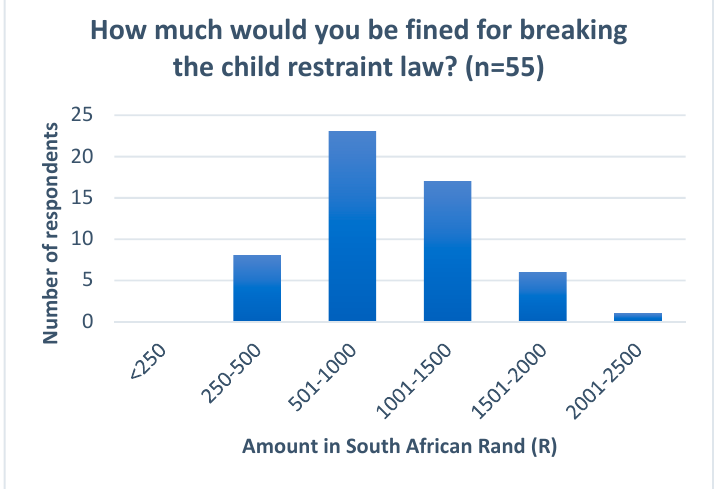
Figure 3. Survey respondent knowledge of fine penalty. Respondent knowledge of fine penalty for breaking the child restraint law. (NB Correct response was <250 Rand).